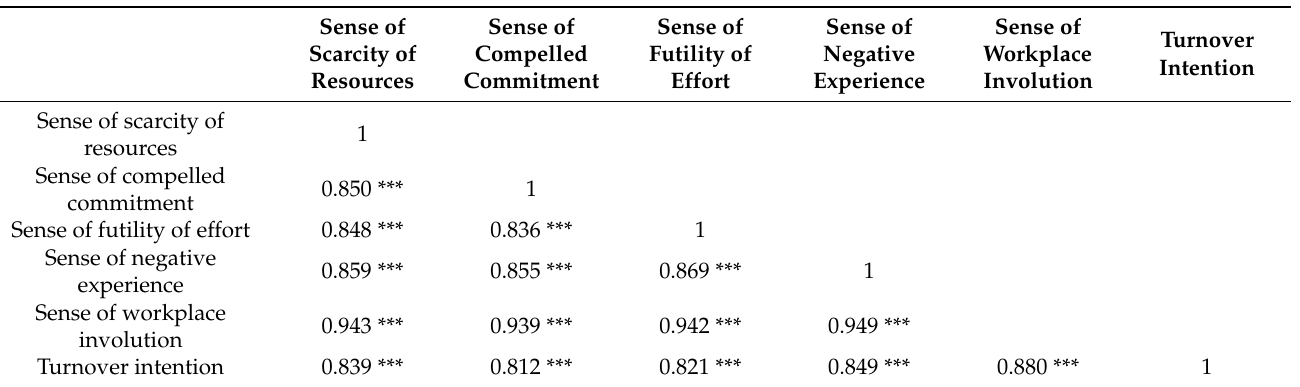
Table 8. Correlation analysis of newly recruited employees’ sense of workplace involution and turnover intention.